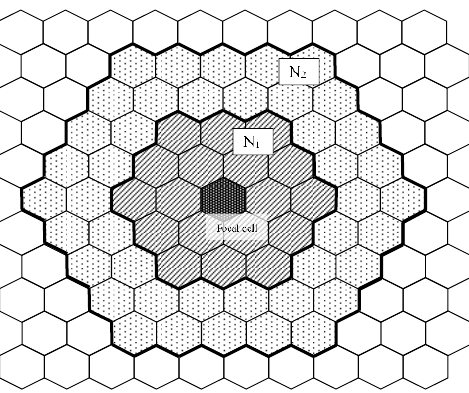
Figure 6. Hexagonal grid field. Here, N 1 is the domain within s meshes of the focal cell. Similarly, N 2 is the sum of the states of the domain within t meshes of the focal cell, assuming that s < t .